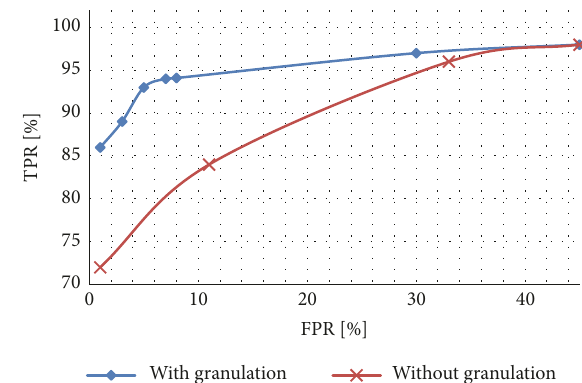
Figure 5: ROC curves for the Chi-Square metric comparing effectiveness of anomaly detection when granules for payload are extracted and otherwise. The experiment was conducted for an algorithm trained on 300 samples.